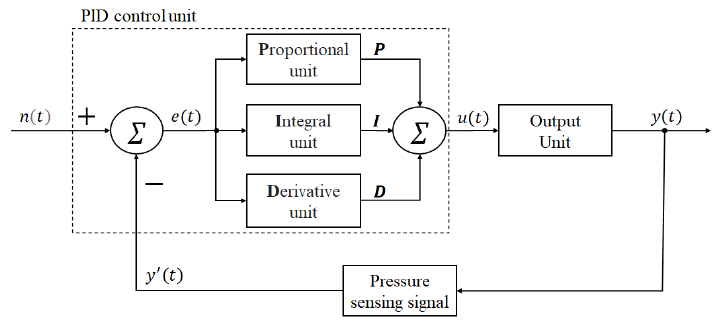
Figure 2. The basic architecture of the PID control unit.